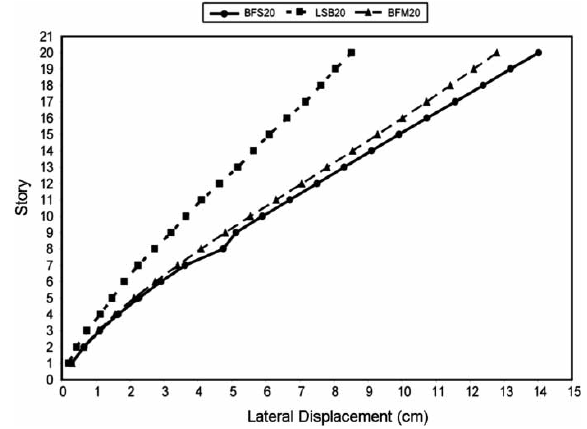
Fig. 15. Lateral displacement of different models